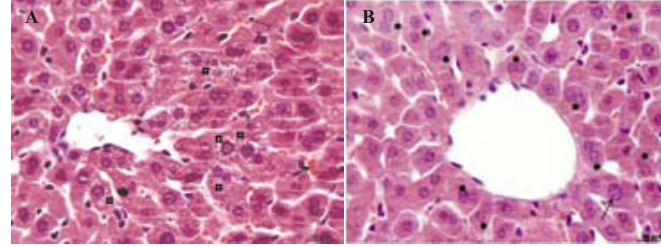
FIGURE 1 - Photomicrographs showing part of the mice liver lobes. A . From H-IR (Hepatectomy + ischemia / reperfusion) group. Notice hepatocytes with cytoplasmatic light areas (¤) and vascular congestion (arrow). B . From H-IR-NAC (Hepatectomy + ischemia / reperfusion treated with N-acetylcysteine) group. Notice large nucleus (arrow) and hepatocytes containing binuclear nucleus (*). H.E.